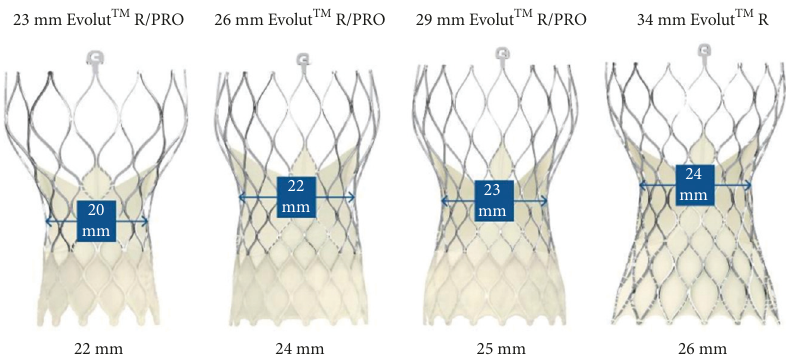
Figure 3: Maximum recommended balloon size for self-expanding CoreValve/Evolut valves (adapted from Chhatriwalla